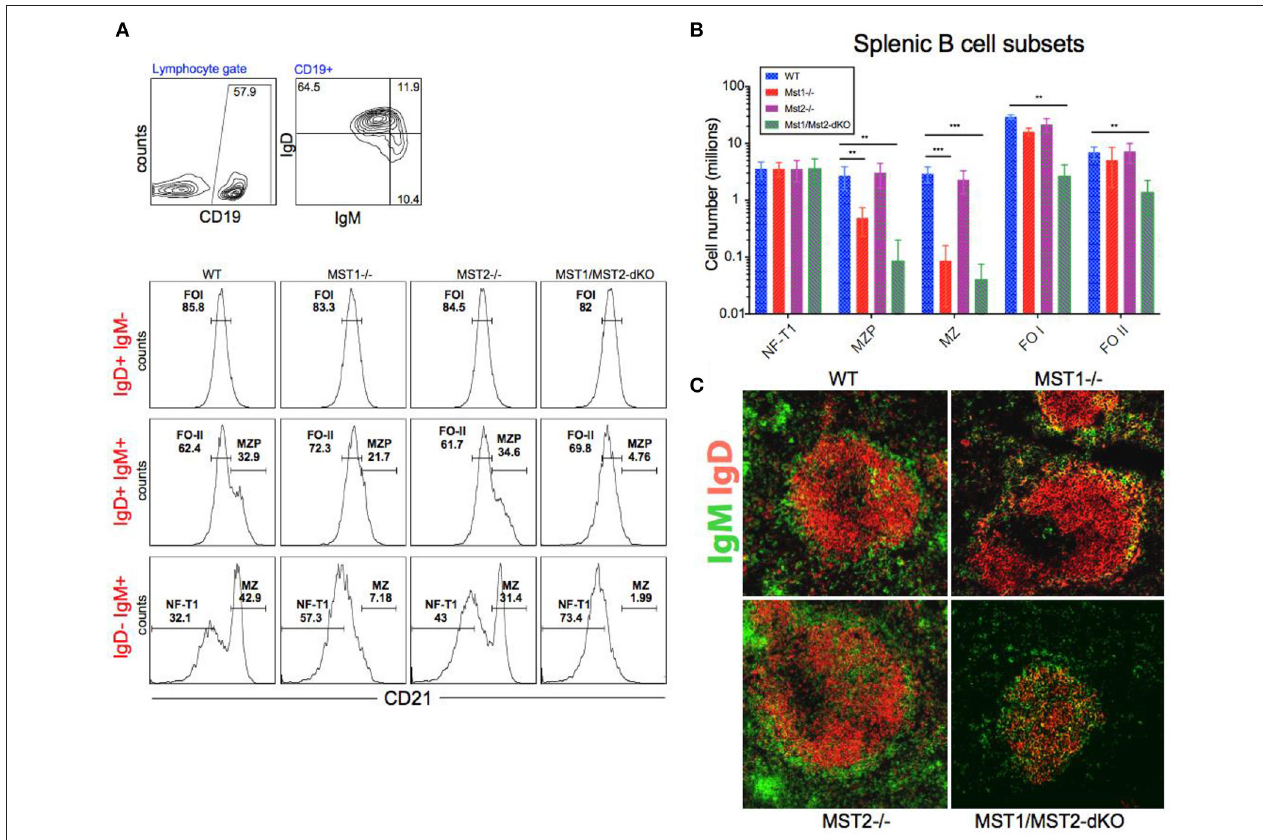
FIGURE 3 | Depletion of Mst1 alone or both Mst1/Mst2 affects the development of MZ B cells as well as FO B cells in the periphery. (A) Flow cytometric analysis shows accumulation of IgD − IgM + i CD21 low NF-T1 B cells in Mst1/Mst2-dKO mice. There is a striking loss of IgD − IgM + CD21 + MZ B cells in Mst1 − / − and Mst1/Mst2-dKO mice. These flow plots are representative of 10 mice analyzed. (Gating strategy: CD19 + IgD − IgM + CD21 low NF-T1 B cell, CD19 + IgD + IgM + CD21 hi MZP B cell, IgD − IgM + CD21 + MZ B cell, CD19 + IgD + IgM − CD21 mid FO I B cell, and CD19 + IgD + IgM + CD21 mid FO II B cell). (B) Absolute counts of different B